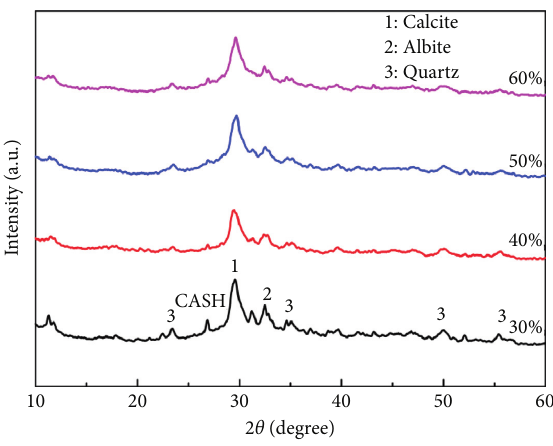
Figure 11: XRD pattern of